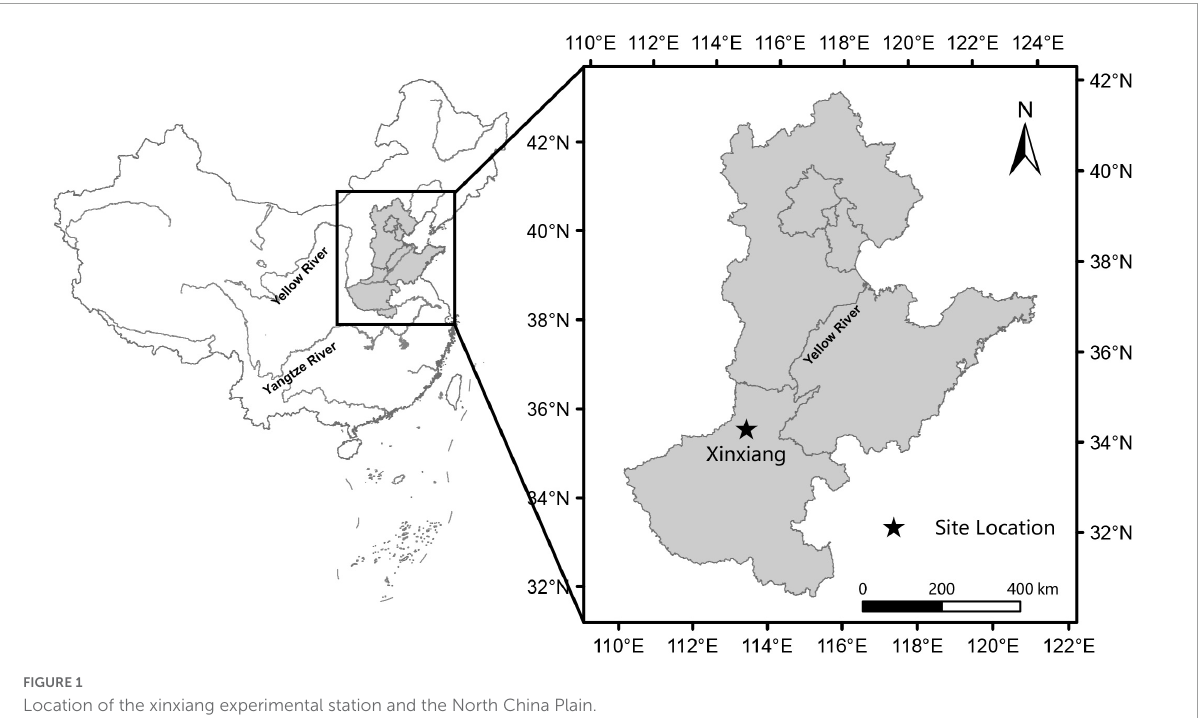
FIGURE1 Location of the xinxiang experimental station and the North China